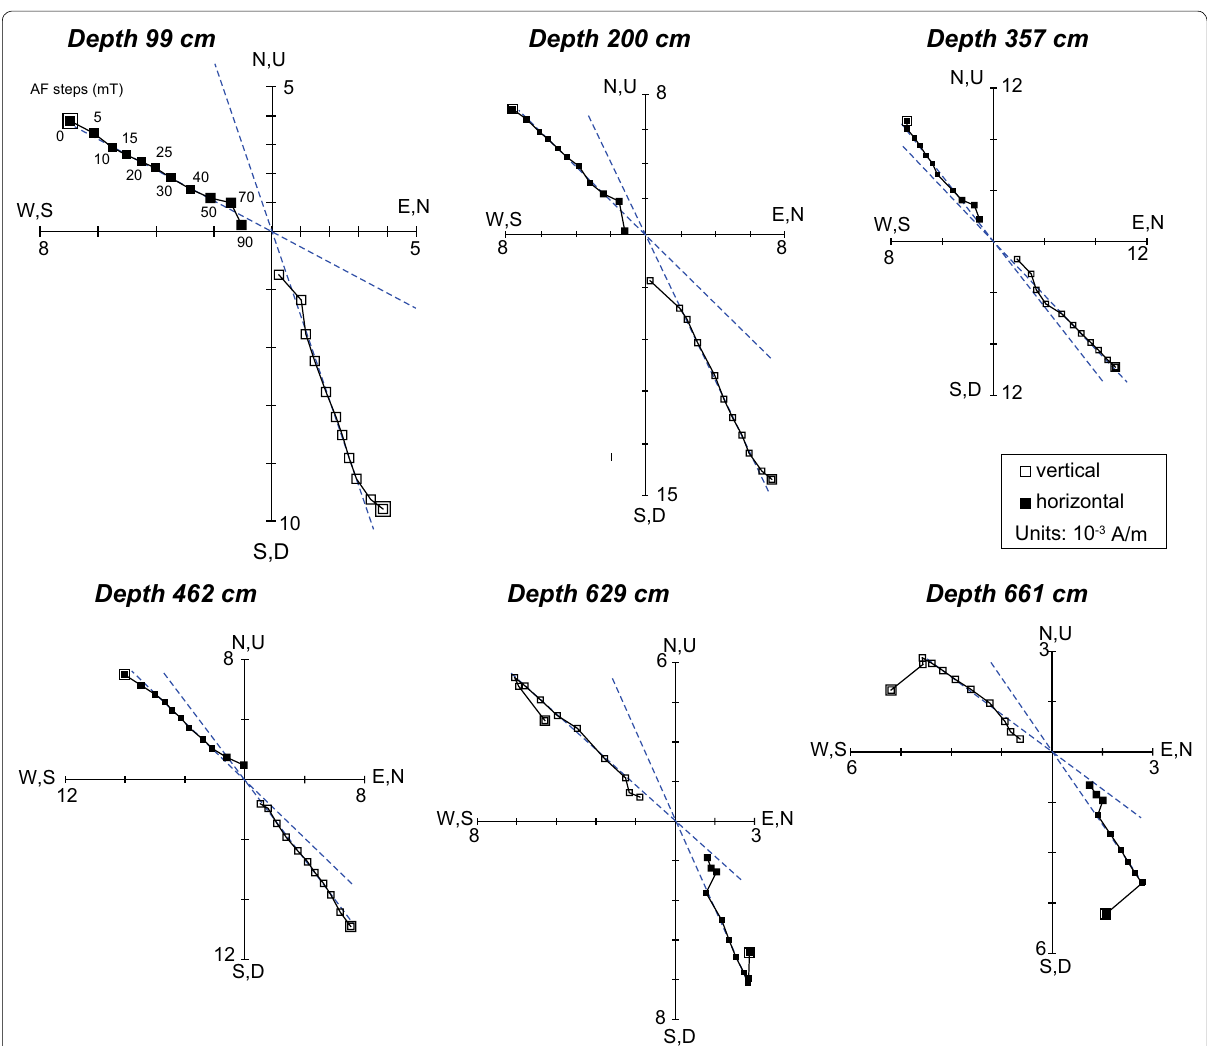
Fig. 2 Representative results of stepwise alternating field (AF) demagnetization on vector diagrams. Solid (open) squares are projections of vector end points onto the horizontal (vertical) plane. The core was not azimuthally